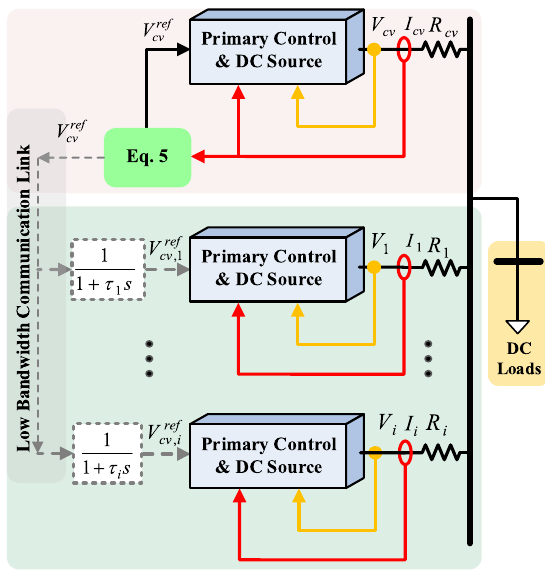
Fig. 3 The proposed secondary control approach based on LBC